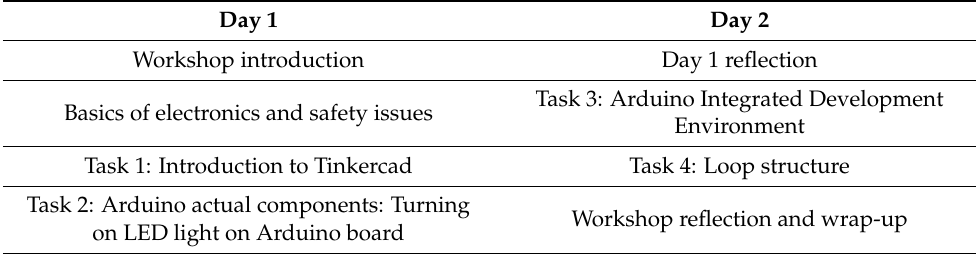
Table 2. The two-day workshop